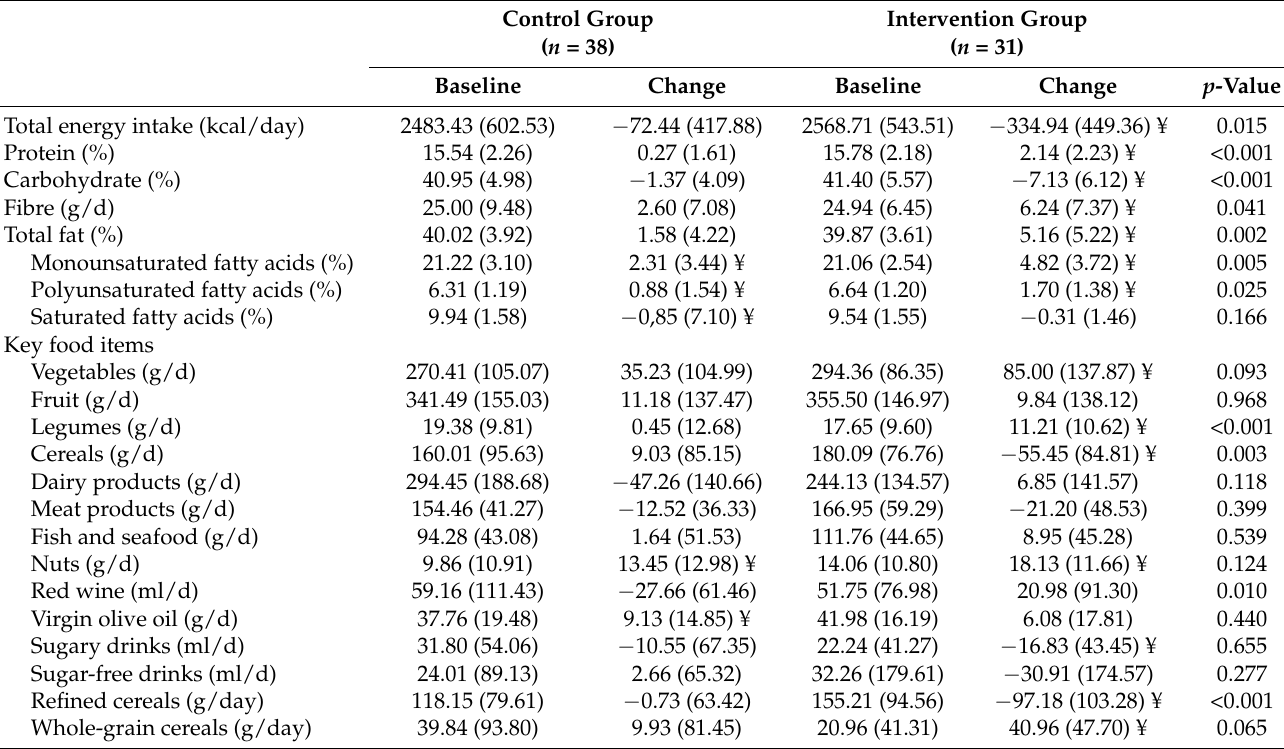
Table 2. Baseline and 1-year changes in energy and nutrient intake, total fat, and key food items by treatment